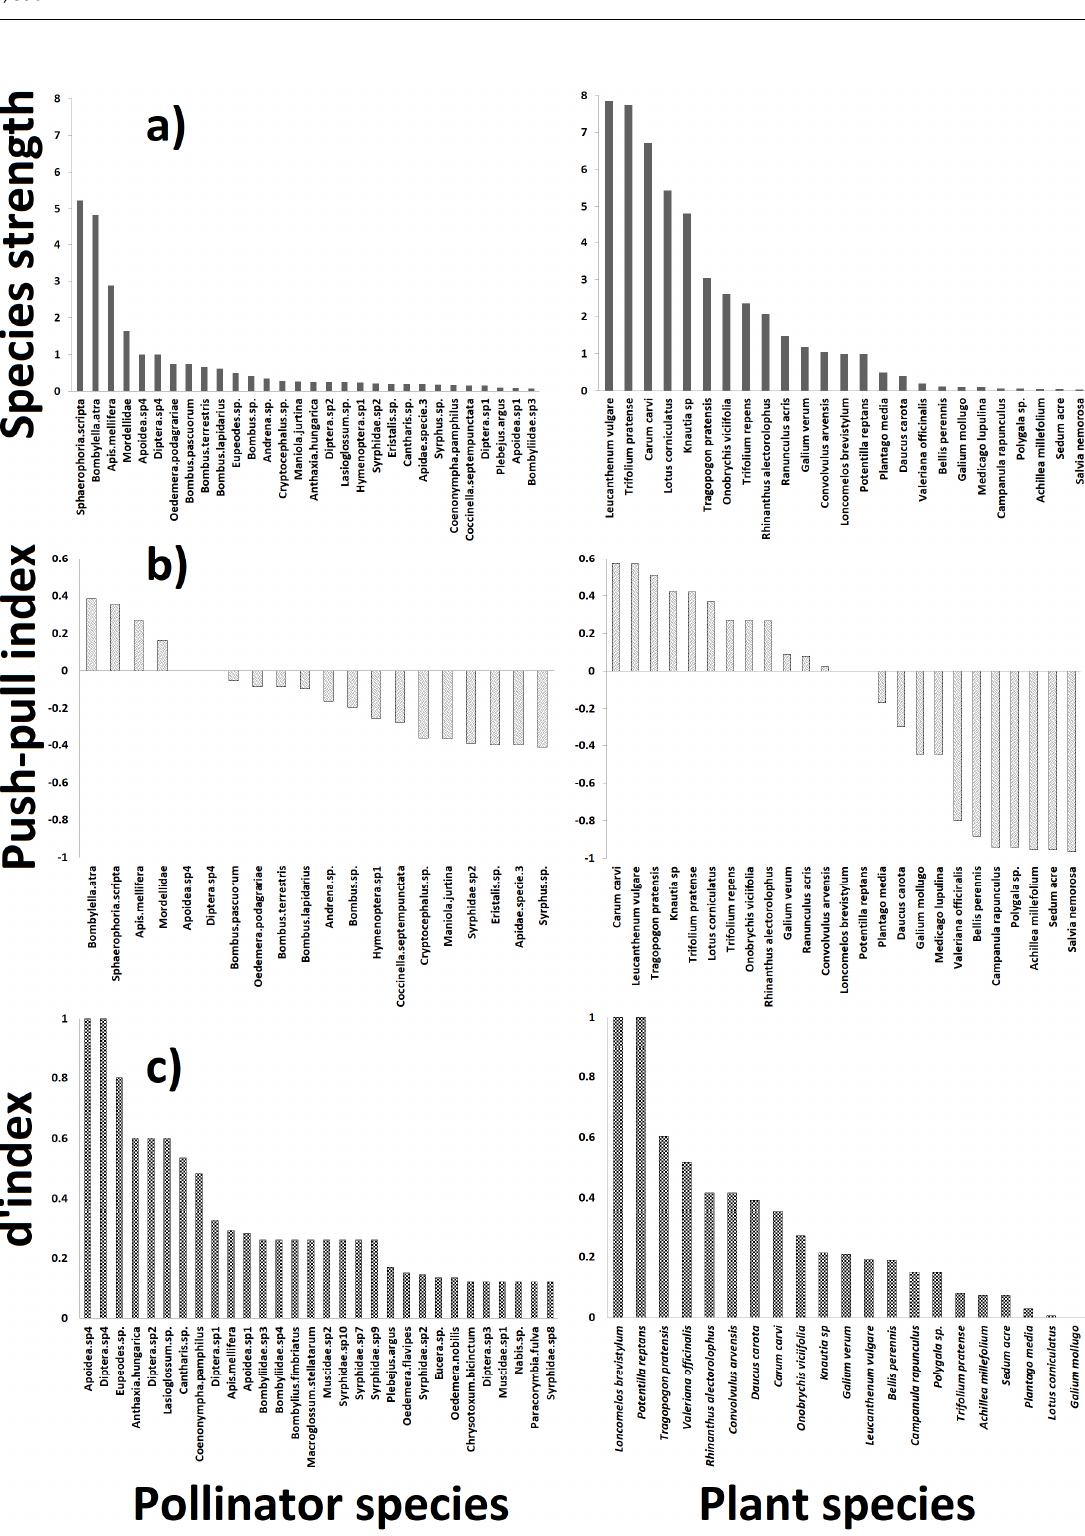
Figure 3. Species descriptors used to characterize the role of each species within the network; cal- culated taking into account the interaction strength between plants and pollinators: ( a ) Species strength : provides a quantitative measure of the importance of a species for its partners; ( b ) Push-pull index (Species interaction asymmetry): provides a measure of the imbalance between the effect that a species has on its partners and the dependence of that species on their partners; ( c ) d (cid:48) index (Generalization- Specialization) provides a measure of the level of a species specialization taking into account the relative abundance of its partners. Plant species authority is shown in Table